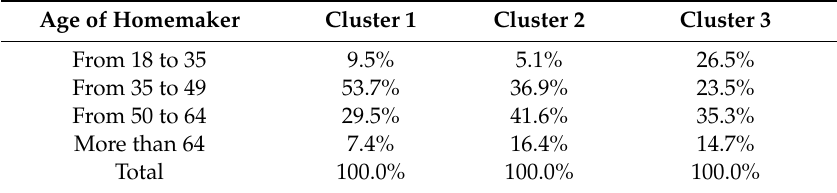
Table 9. Crosstab for cluster membership and age of homemaker